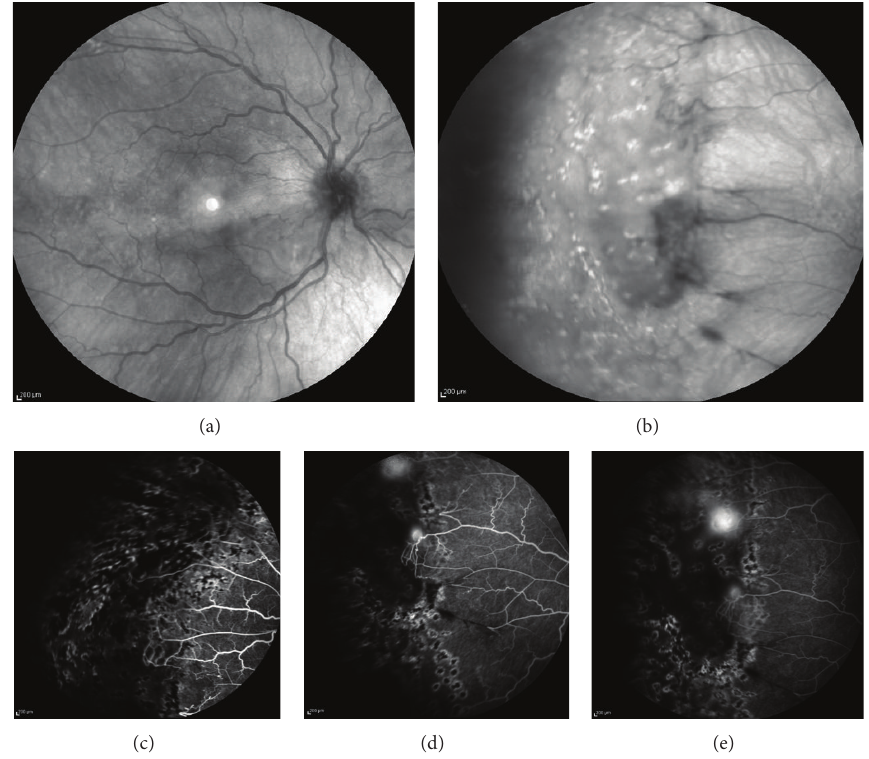
Figure 4: (a, b) Infrared fundus photo of the right eye, showing no vitreous hemorrhage and presence of fibrotic tissue at the site of previous neovascularization, as well as presence of laser photocoagulation spots in the periphery; (c–e) fluorescein angiography, showing coverage of previous ischemic areas with scatter laser photocoagulation and improvement of sea fan neovascularization, with only slight leakage hyperfluorescence in the photocoagulated